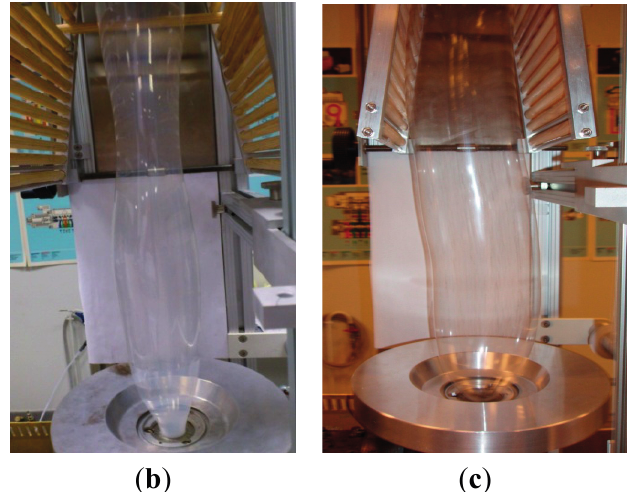
Figure 14. ( a ) Stability maps (BUR versus TUR) of modified PLA with 0.7 wt% of Joncryl. Comparison of the bubble shape between ( b ) PLA and ( c ) PLA–0.7; Unlike PLA,